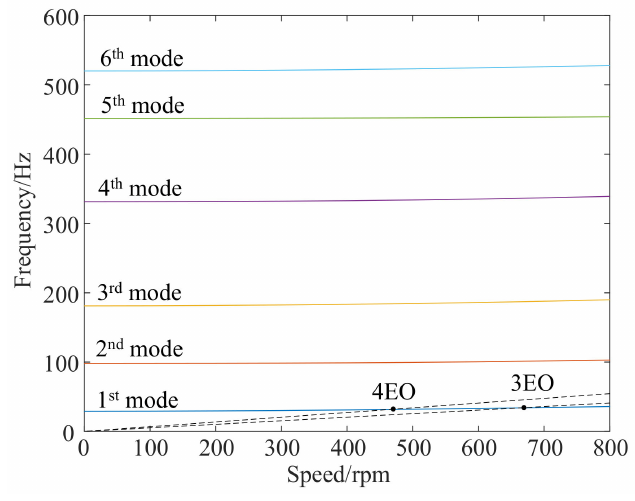
Figure 12. Campbell diagram of FEM. Table 1. Ratio k in different blade synchronous vibration crossover points of